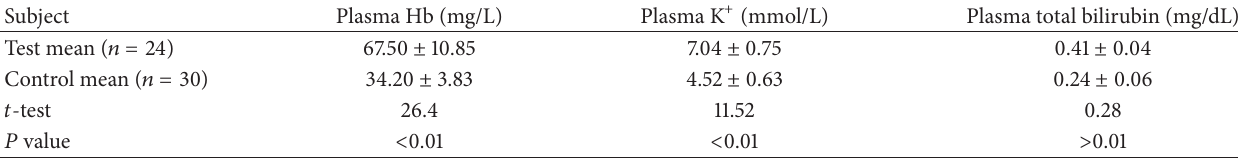
Table 2: Table of significance comparing test and control plasma haemoglobin, potassium, and bilirubin concentration.